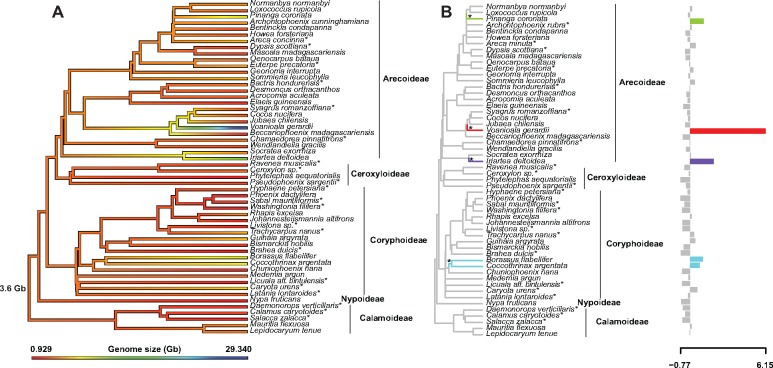
—Ancestral state reconstruction of genome size (in kilobases, kb) in the palms under (A) Brownian Motion, where “3.6 Gb” is the ancestral estimate for the palms and (B) genome size under an Ornstein–Uhlenbeck model. Asterisks next to species names indicate a different species of the same genus was sampled in the phylogenetic tree; asterisks next to branches in (B) represent significant trait shifts (n = 4 shifts, BIC = 991.3; Pagel’s λ =  7.8 × 10−5, P = 1.0; Blomberg’s K = 0.47, P = 0.60).